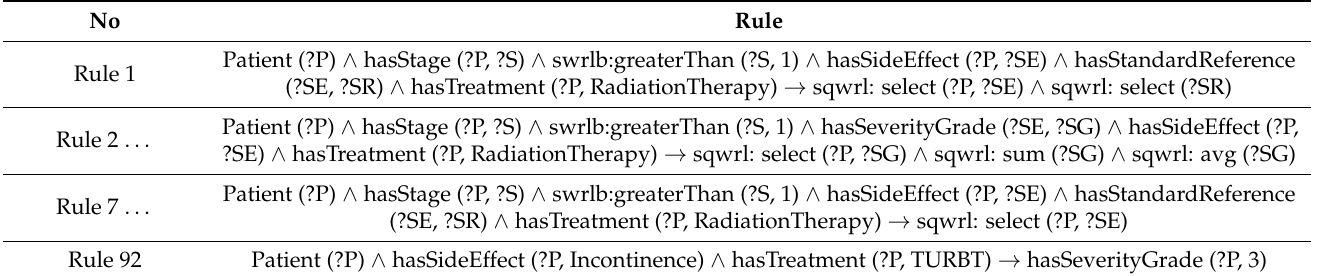
Table 6. Examples of operator-defined reasoning rules from our rule-base.